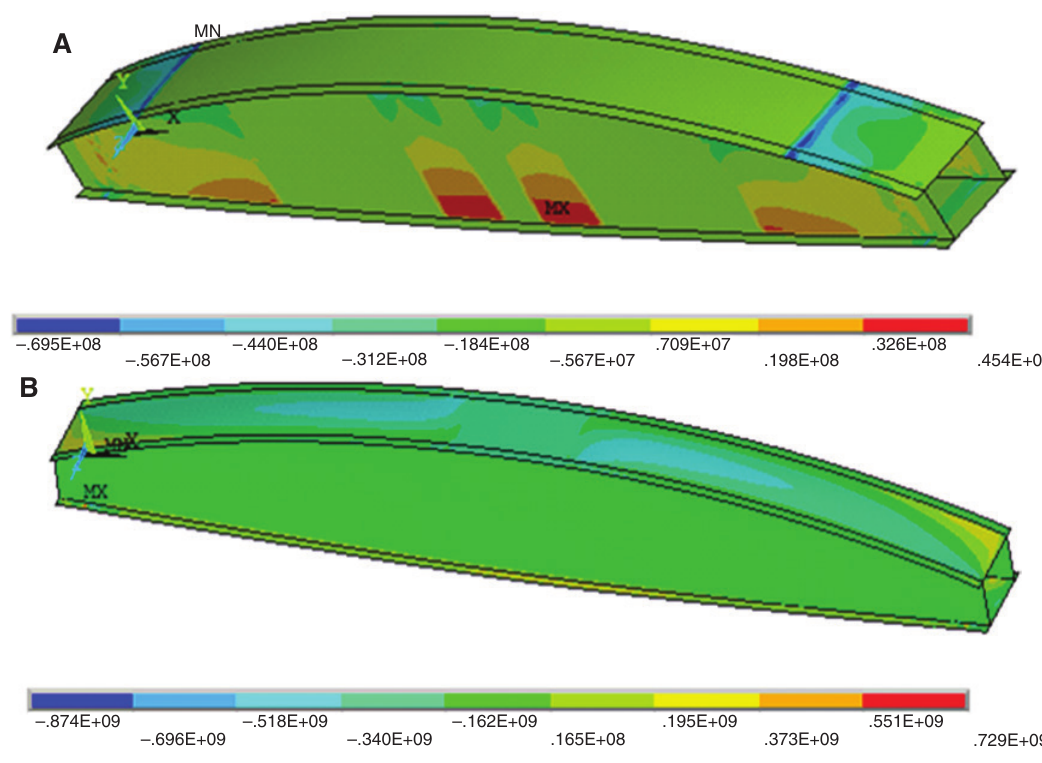
Figure 7: Stress distribution in composite box girder before (A) and after (B) optimization.